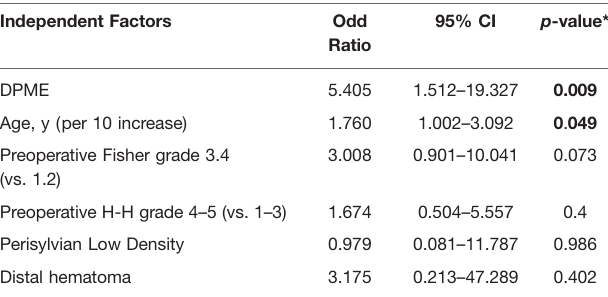
TABLE 4 | Multivariable analysis of possible outcome